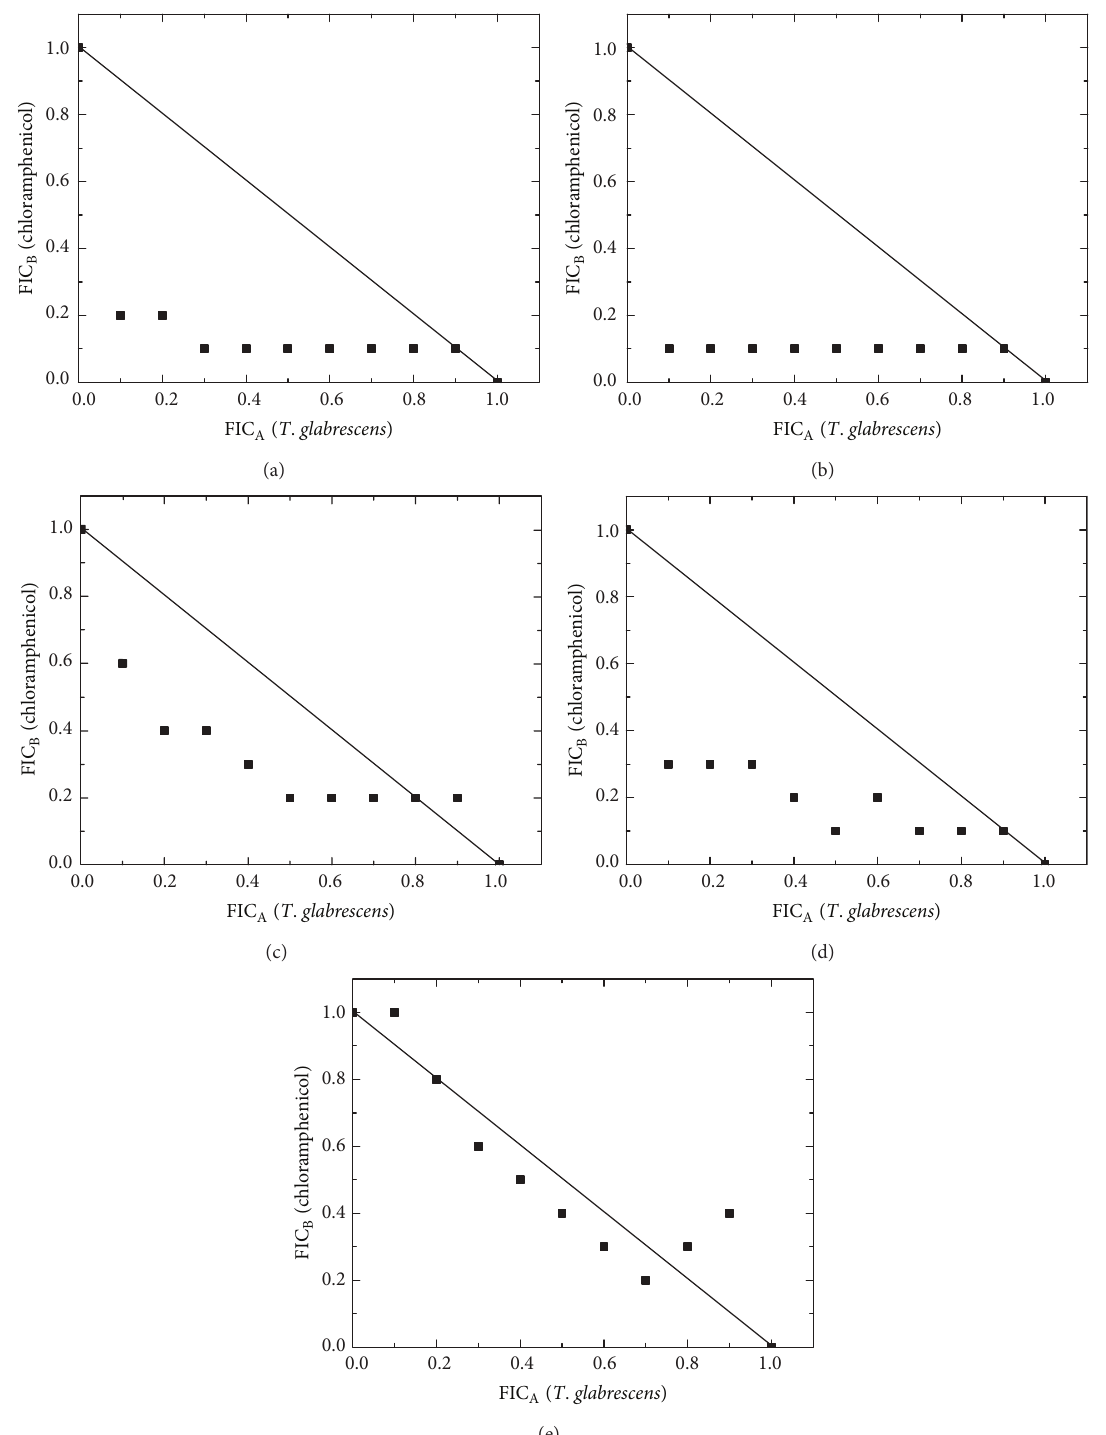
Figure 1: The derived isobolograms for the interaction of T. glabrescens oil-chloramphenicol and their treatment outcomes against the following: (a) E. coli ATCC 25922, (b) K. pneumoniae ATCC 700603, (c) P. mirabilis ATCC 12453, (d) P. aeruginosa ATCC 27853, and (e) S. aureus ATCC